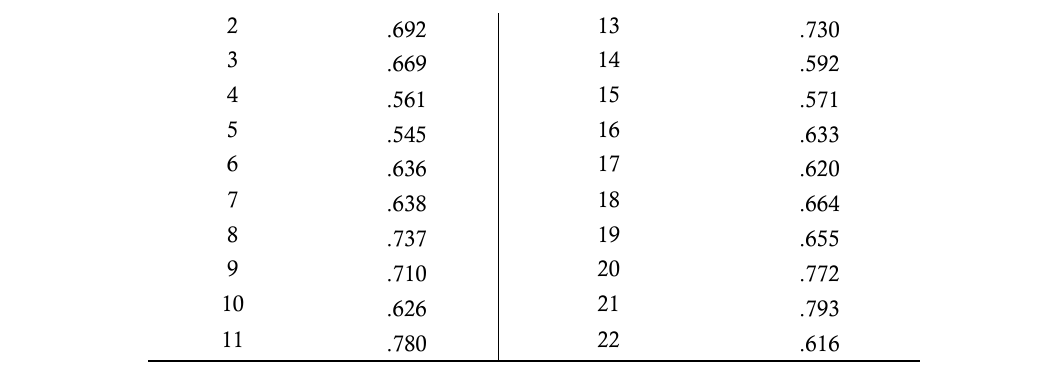
Tabel 3. Total Variance Explained